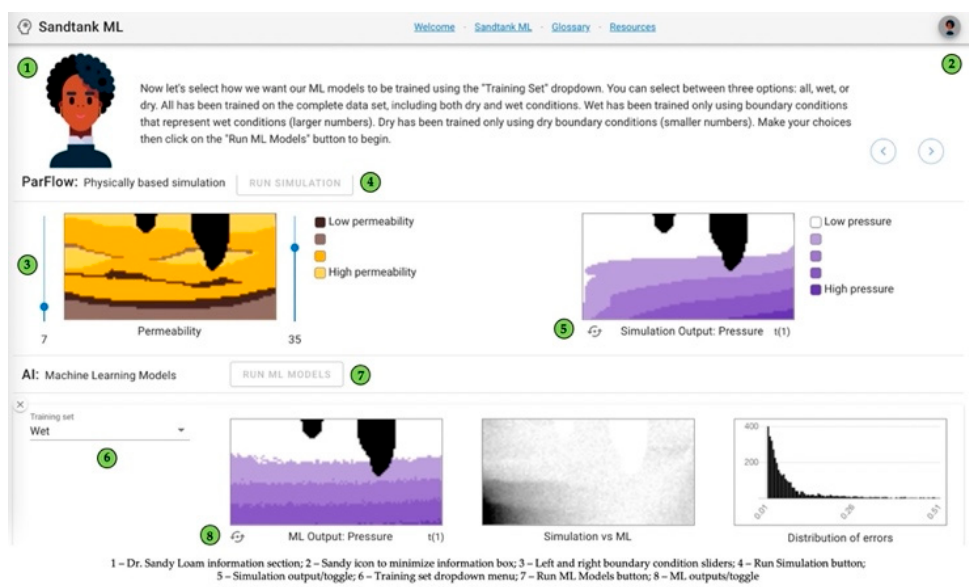
Figure 2. Overview of the Sandtank-ML application with labelled features.